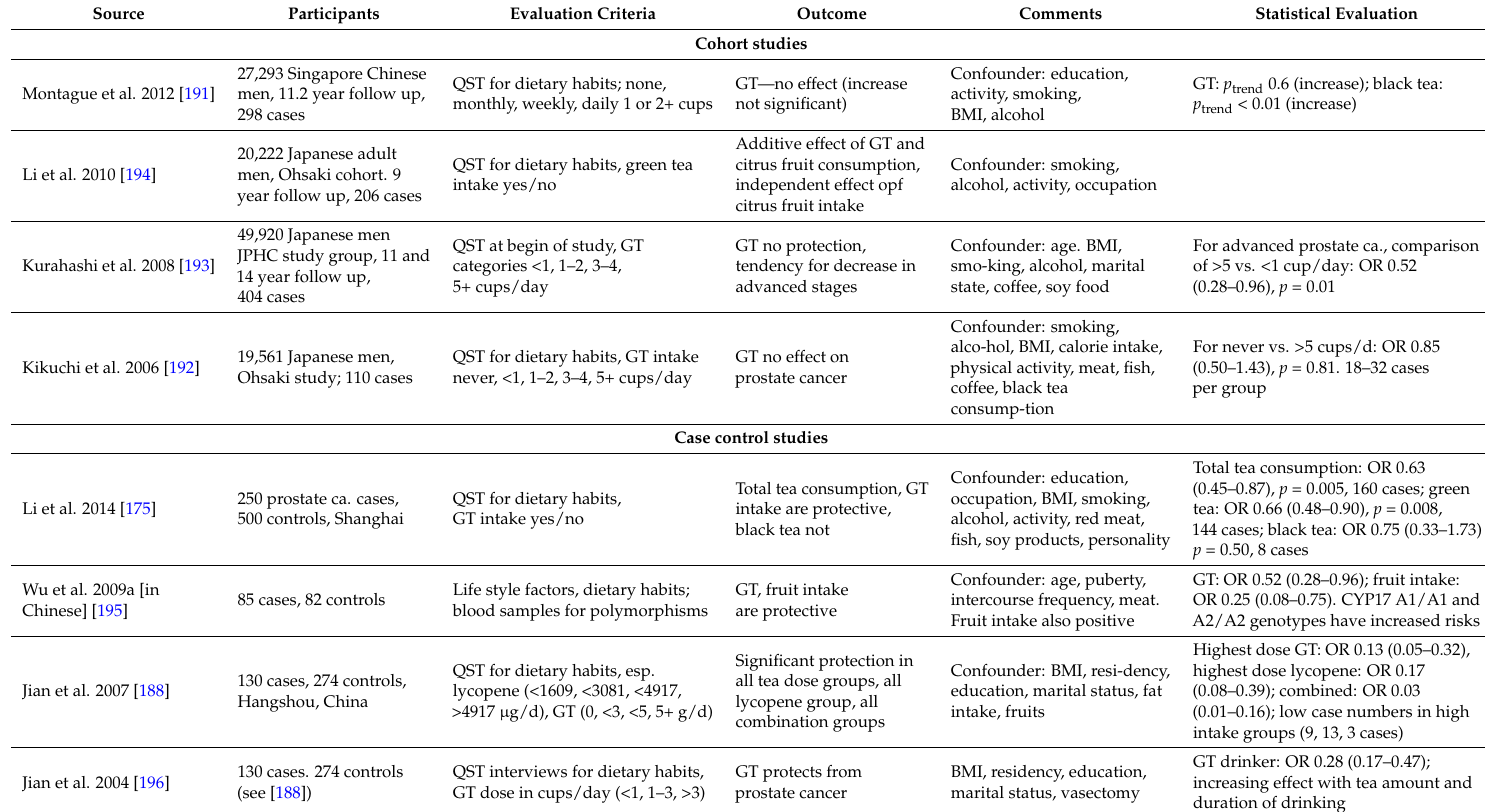
Table 6. Epidemiological studies for GT and prostate